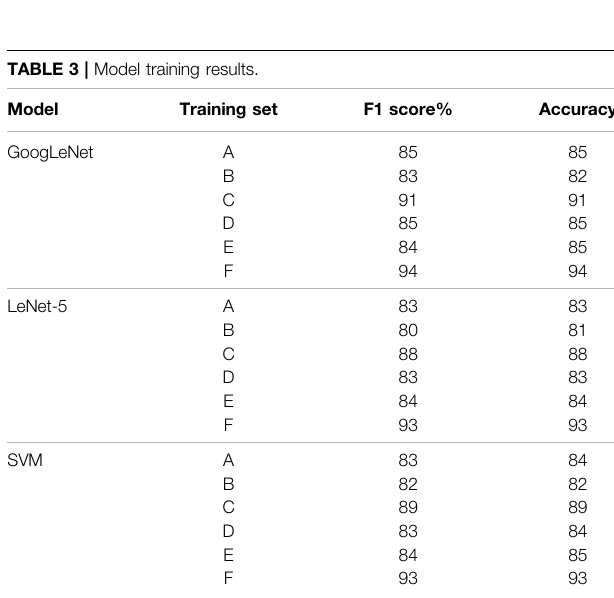
FIGURE 6 | Generated sample example.